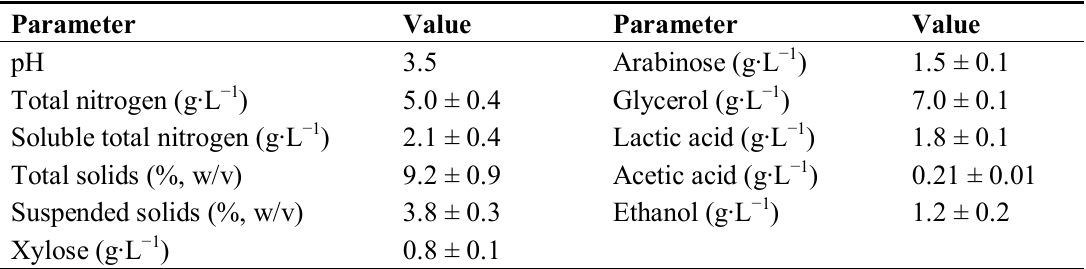
Table 1. Characterisation of the industrial thin stillage derived from wheat-based ethanol production process used in the present